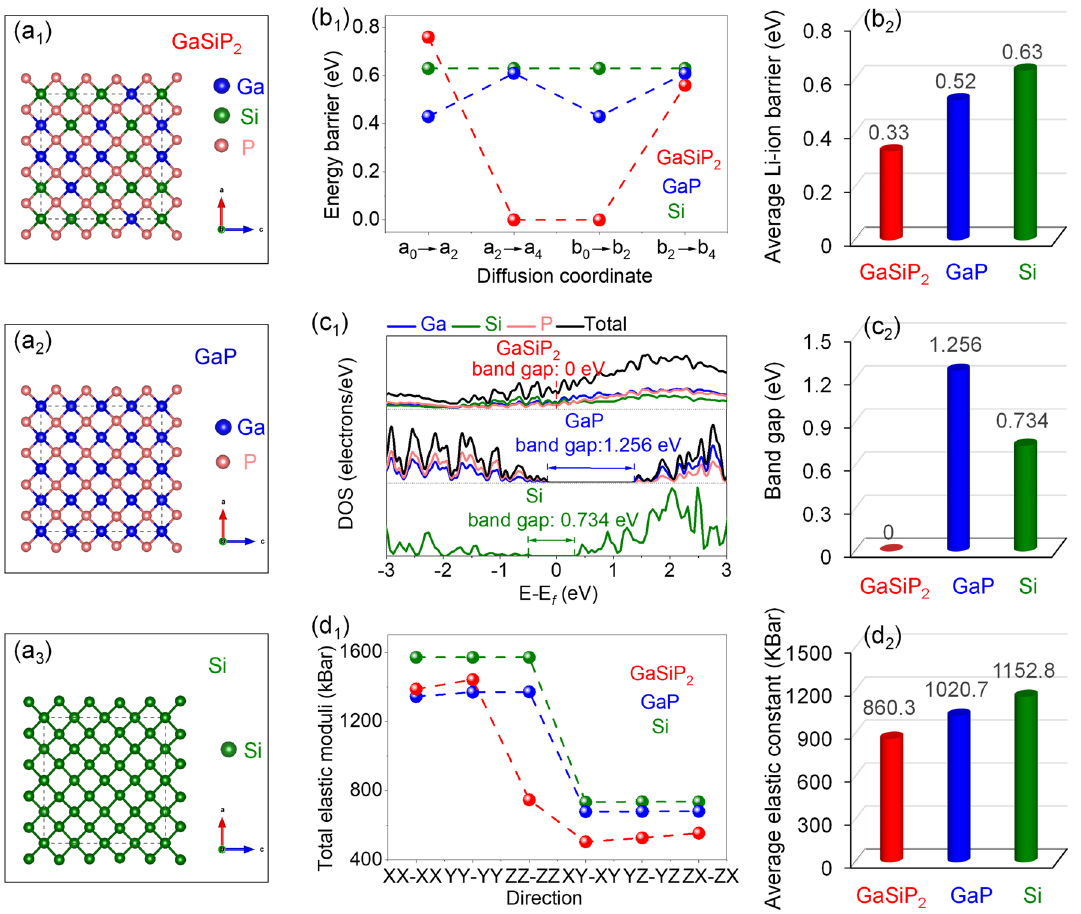
Fig. 1 Physicochemical properties resolved by first-principles calculations of the cation-mixed GaSiP 2 compound, GaP and Si: a 64-atom super- cell; b Li-ion diffusion barrier energies; c DOS; d Elastic